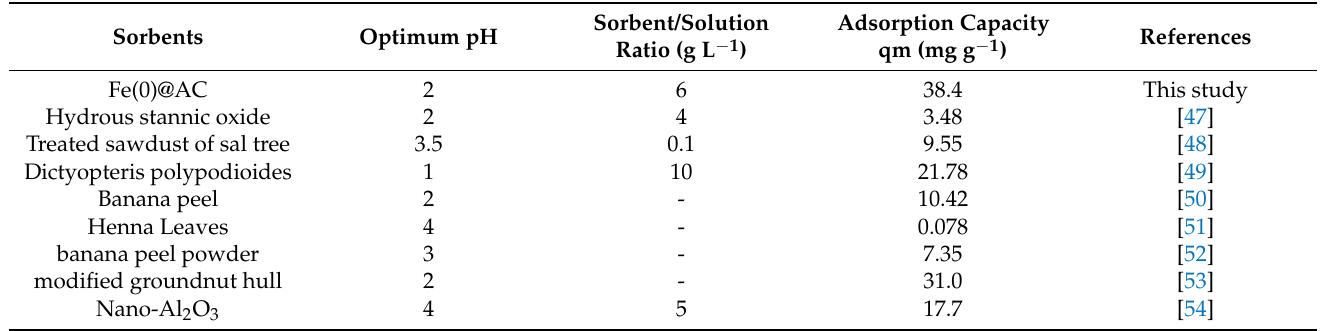
Table 2. Comparison of adsorption capacity and pH of solution for Cr (VI) removal of with reported different